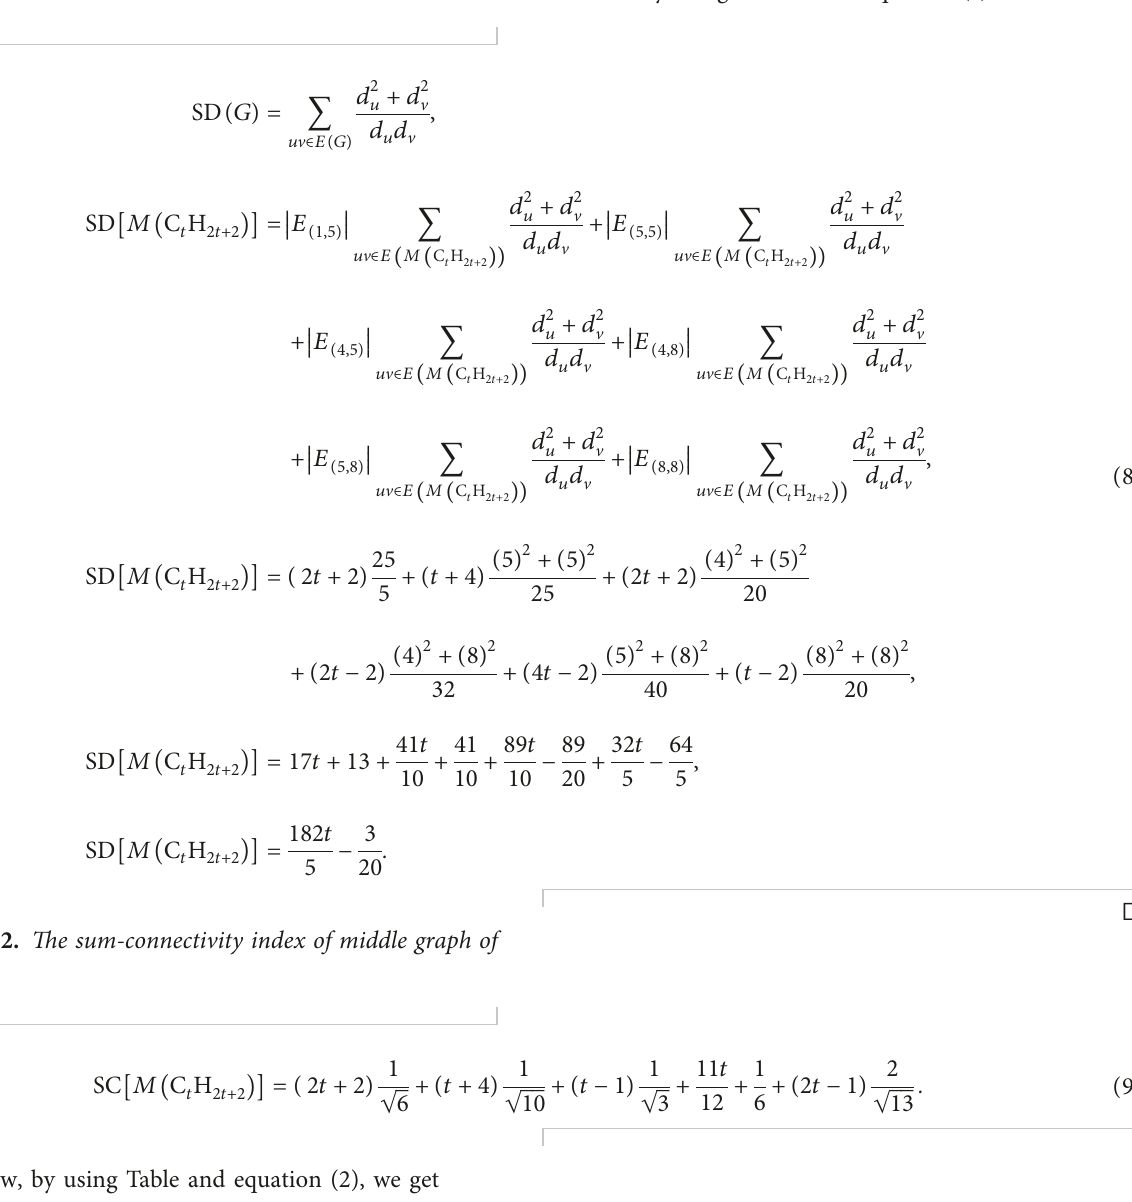
Table 1: Edge division based on the degree of end vertices of each edge. E [ d , d ] E u v